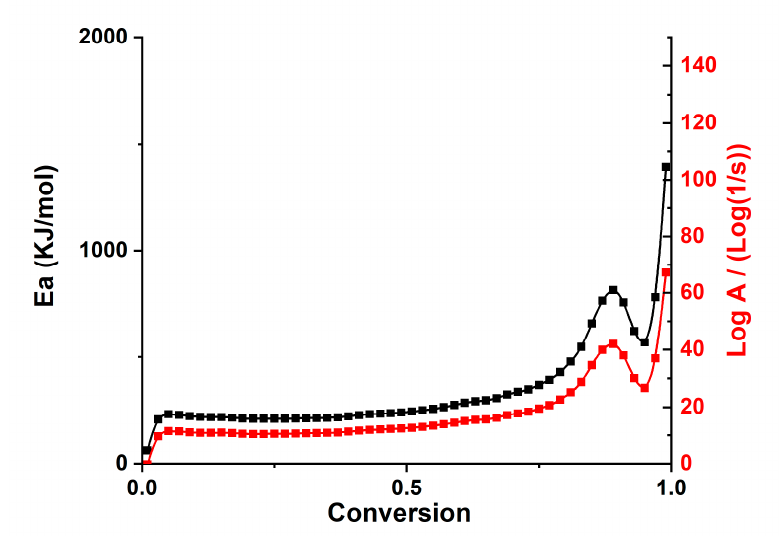
Figure 5. Activation energy (black) and pre-exponential factor (red) plot for PEEK under nitrogen, obtained by Friedman analysis.